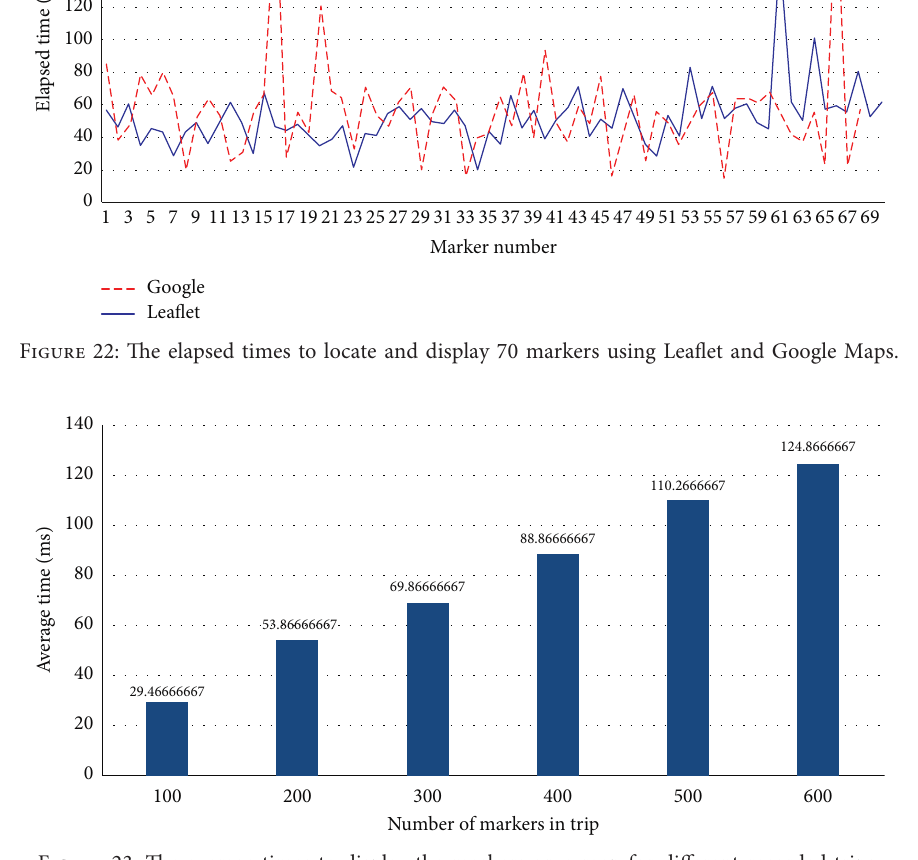
Figure 23: The average times to display the markers on a map for different recorded